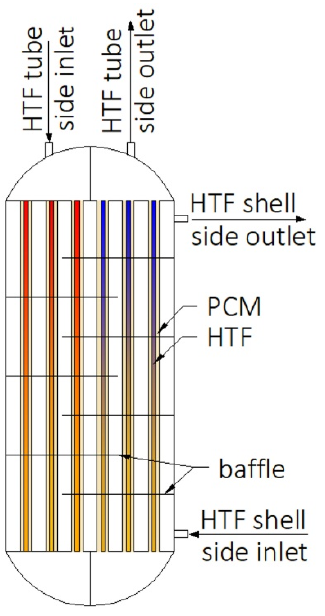
Figure 17. Heat exchanger designed by Lin et al. [148,149].